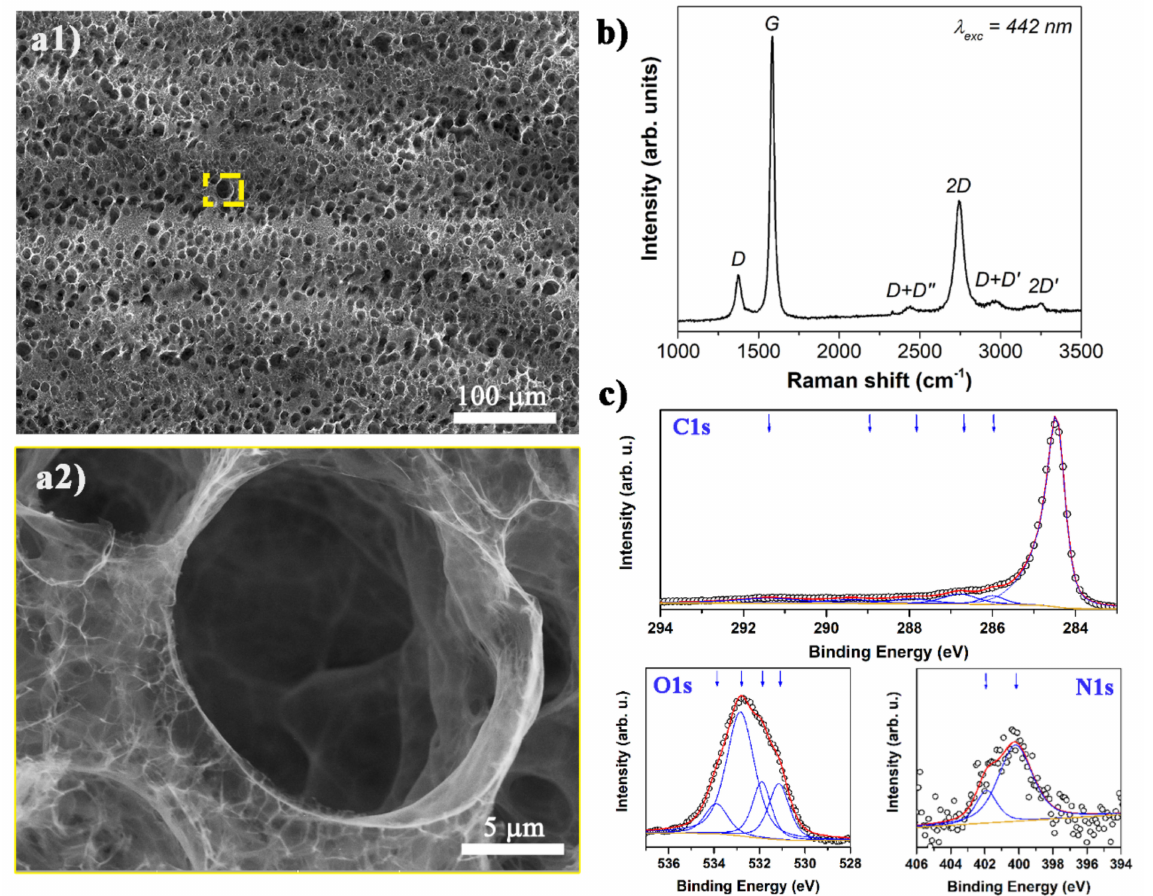
Figure 2. LIG surface characterization. ( a1 ) SEM image of LIG; ( a2 ) High magnification SEM image of a pore in image ( a1 ) highlighted with a dash red line; ( b ) Raman spectrum using 442 nm laser excitation wavelength; and ( c ) XPS spectra of C1s, O1s e N1s regions, red, blue and yellow lines refers to the original spectra, the deconvoluted peaks and the baseline used,